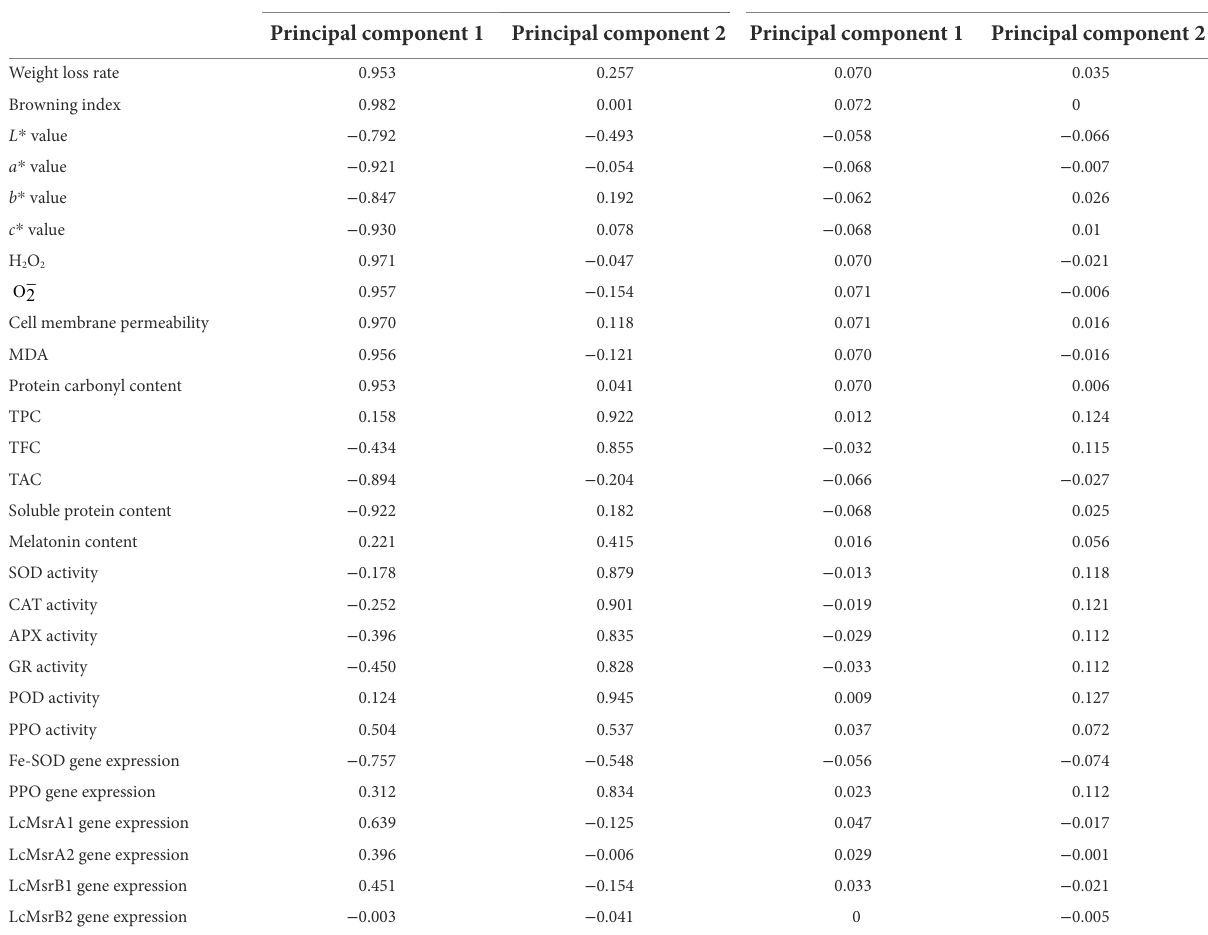
TABLE 2 Loading coefficients and eigenvectors of the principal